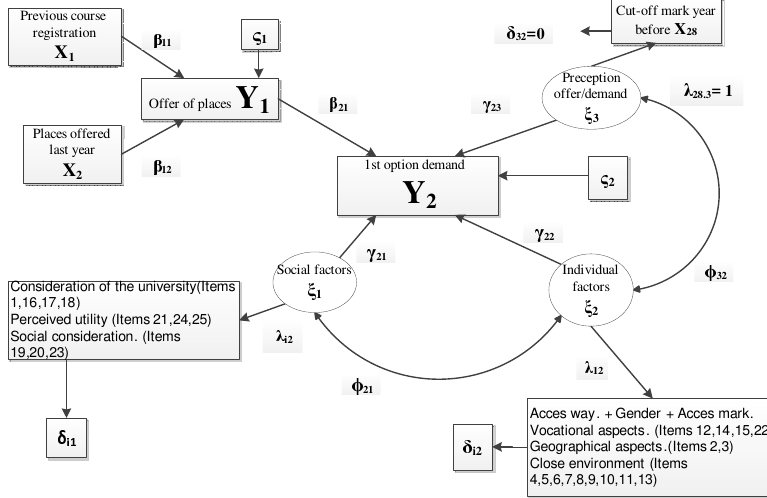
Figure 1. Diagram of the structural